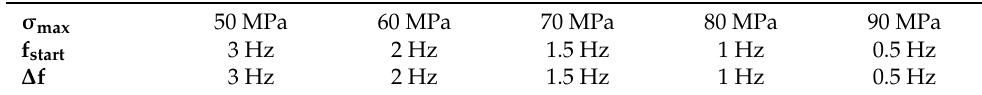
Table 2. MFT parameters for self-heating investigation.